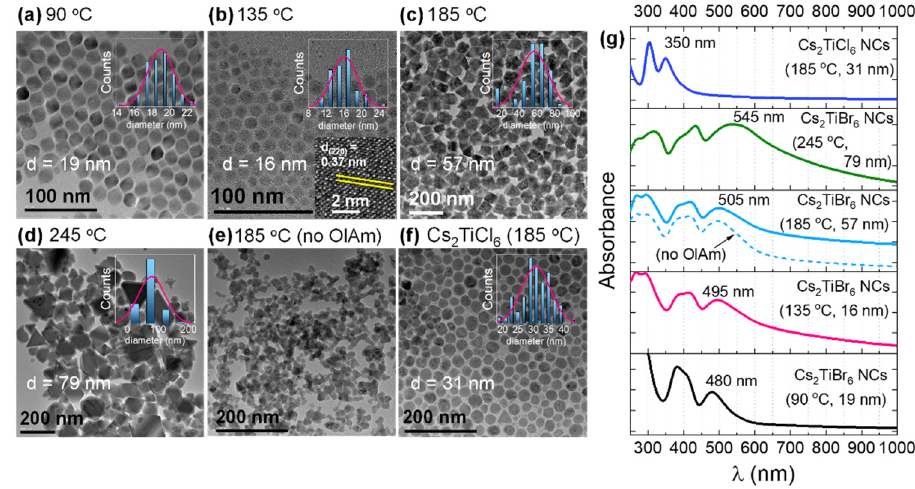
Figure 2. Temperature-dependent morphology evolution and absorption of Cs 2 TiBr 6 NCs. TEM images of Cs 2 TiBr 6 NCs synthesized at ( a ) 90 °C, ( b ) 135 °C, ( c ) 185 °C, ( d ) 185 °C, but with no OlAm, and ( e ) 245 °C. ( f ) TEM image of Cs 2 TiCl 6 NCs synthesized at 245 °C. The corresponding size distributions and the average size ( d ) of the NCs are depicted in the respective panels. The inset of ( b ) represents a HRTEM image of a Cs 2 TiBr 6 NC, where the spacing between (220) lattice planes is shown. ( g ) The absorption spectra of the NCs present in ( a – f ) panels in hexane. The corresponding synthesis temperature, size, and the absorption peak maxima of the NCs are denoted near the absorption spectra.